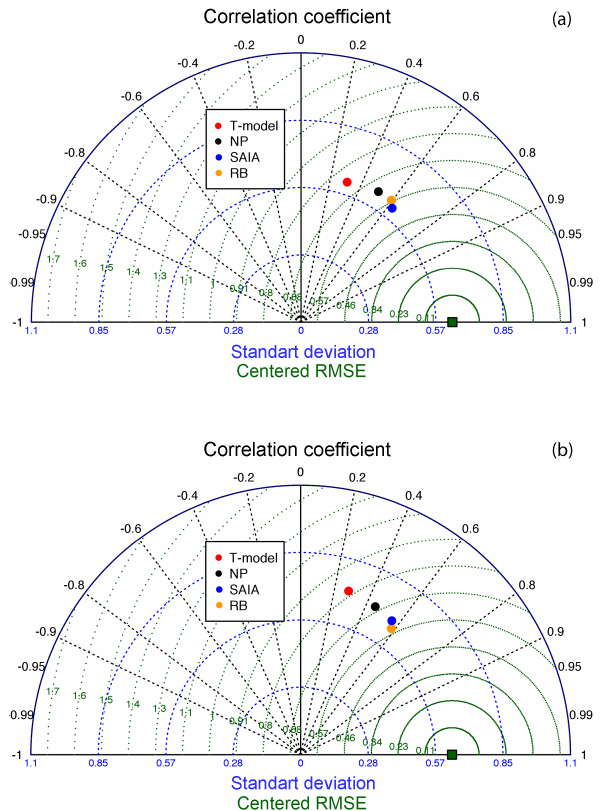
Figure 3. (a) Statistical comparison between cross-correlation, cross-RMSE correlation and standard deviation (Taylor diagram) of the hindcasts for the summer SST field performed with different models initialized in summer. The model variables are the Niño3.4 Index, the WWV Index and another index identified from different extratropical regions: NP (black), SAIA (purple) and RB (orange). T-model is depicted with a red circle. (b) as in (a) but for the sum- mer HC field.